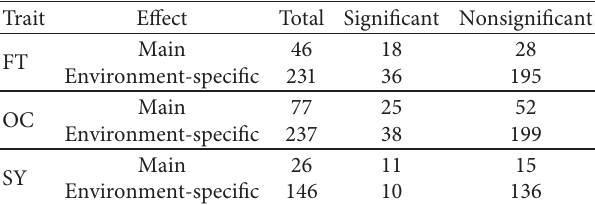
Table 1: The total number of QTL detected by LASSO and the frequency of significant and nonsignificant QTL by OLS post- LASSO (significance level α � 0.05).